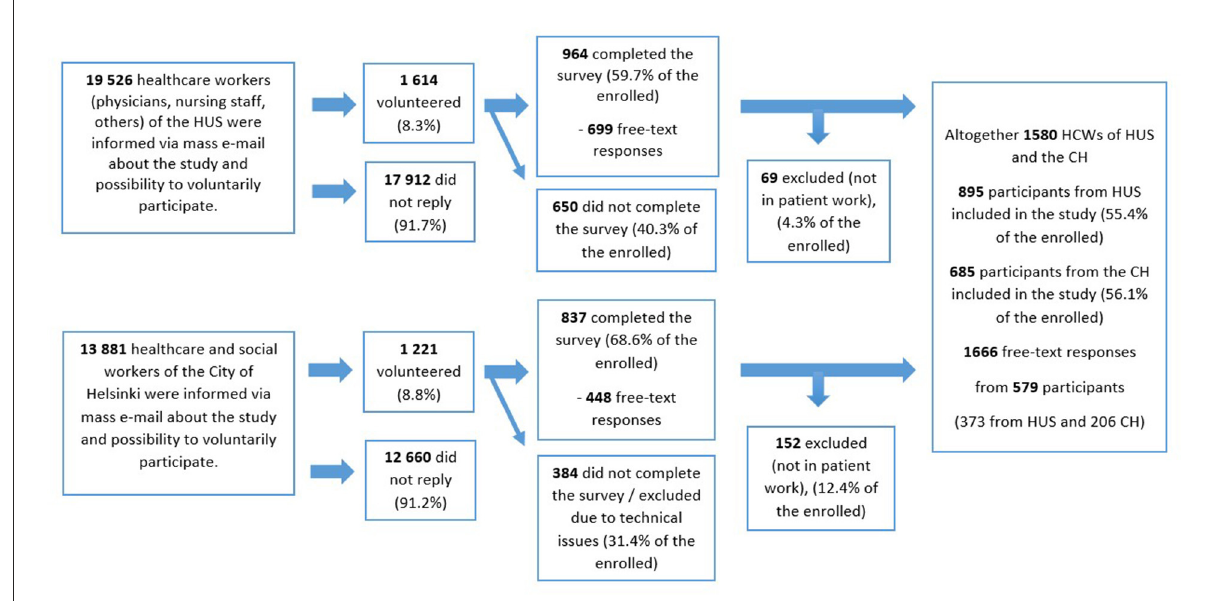
FIGURE2 Questionnaire survey of workers at Helsinki University Hospital (HUS, tertiary healthcare) and the City of Helsinki (CH, primary healthcare).